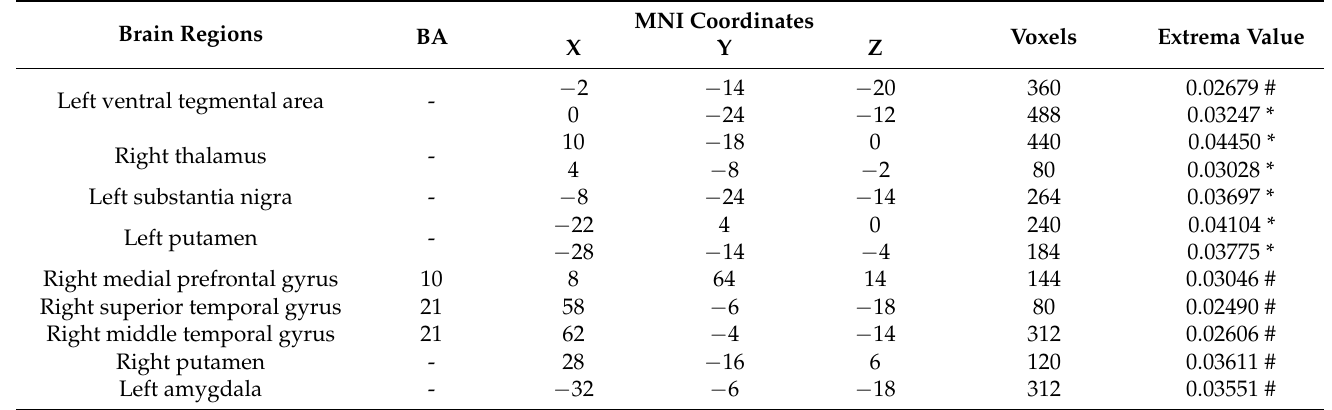
Table 2. Coordinates of the maxima in the activated brain regions associated with maternal love.